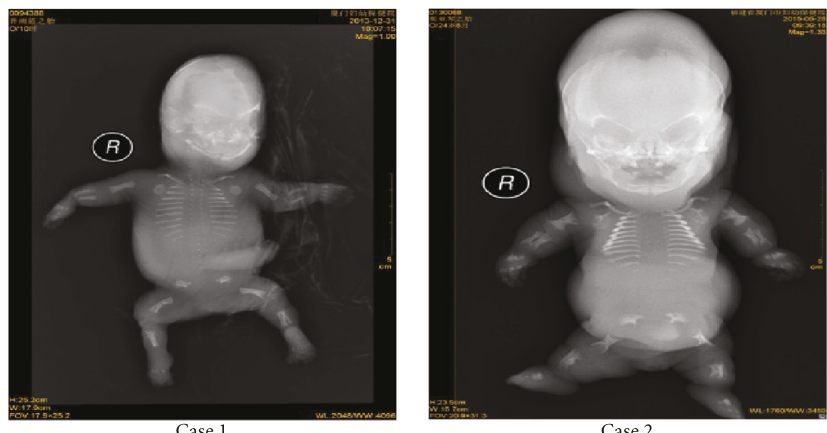
Figure 2: Radiography shows defective skull ossification; vertebral bodies unossified; short, cupped ribs, no fractures; iliac bone ossification limited to the upper part, giving a paraglider-like appearance; long bones, severely short; absence of ossification of all limbs.